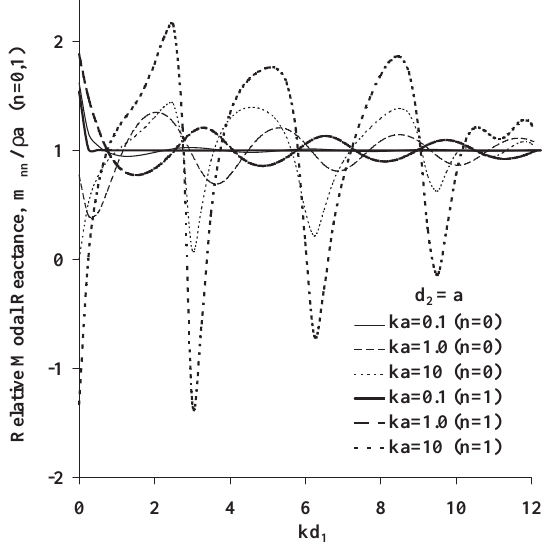
Fig. 5. Relative acoustic reactance for a pulsating and an oscillating source placed near the rigid boundary of an acoustic quarterspace at d 2 = a as a function of the separation parameter, kd 1 , at selected excitation frequencies. Incorporating Eq. (17) into Eq. (15), the modal surface pressures can simply be related to modal surface